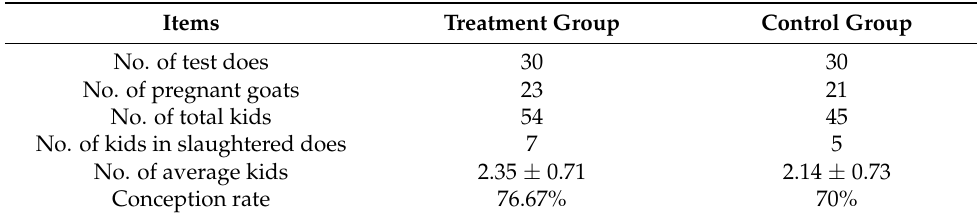
Table 3. The effect of NAC on the reproductive performance of Qianbei Ma goats.